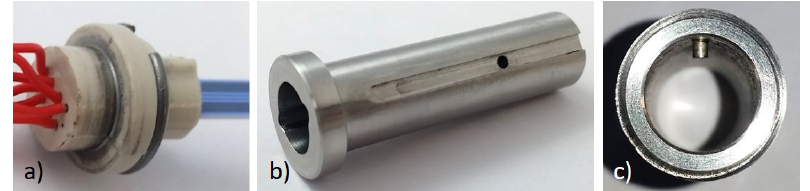
Figure 2. Developed sensor housing for defined horizontal sensor mounting as a modular setup: ( a ) two half shells (PEEK) clamp the ceramic sensor substrate together with electric contact wires; ( b ) a stainless steel adapter fits the flange ( c ), which is welded to the flue pipe of the chimney.